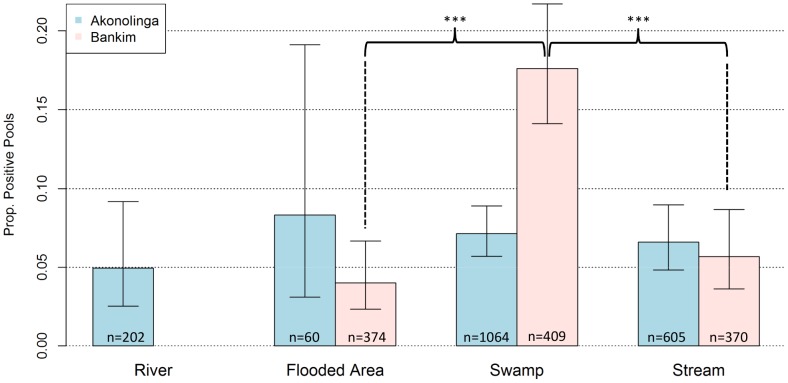
Overall distribution of M.ulcerans in aquatic ecosystems.Bars represent total proportion of M. ulcerans DNA positive sample-pools from each type of ecosystem in Akonolinga (blue) and Bankim (red). Whiskers indicate 95% Confidence intervals for the proportions. Asterisks represent significant differences in positivity between ecosystems within each region (χ2 test, p-value<0.0001).